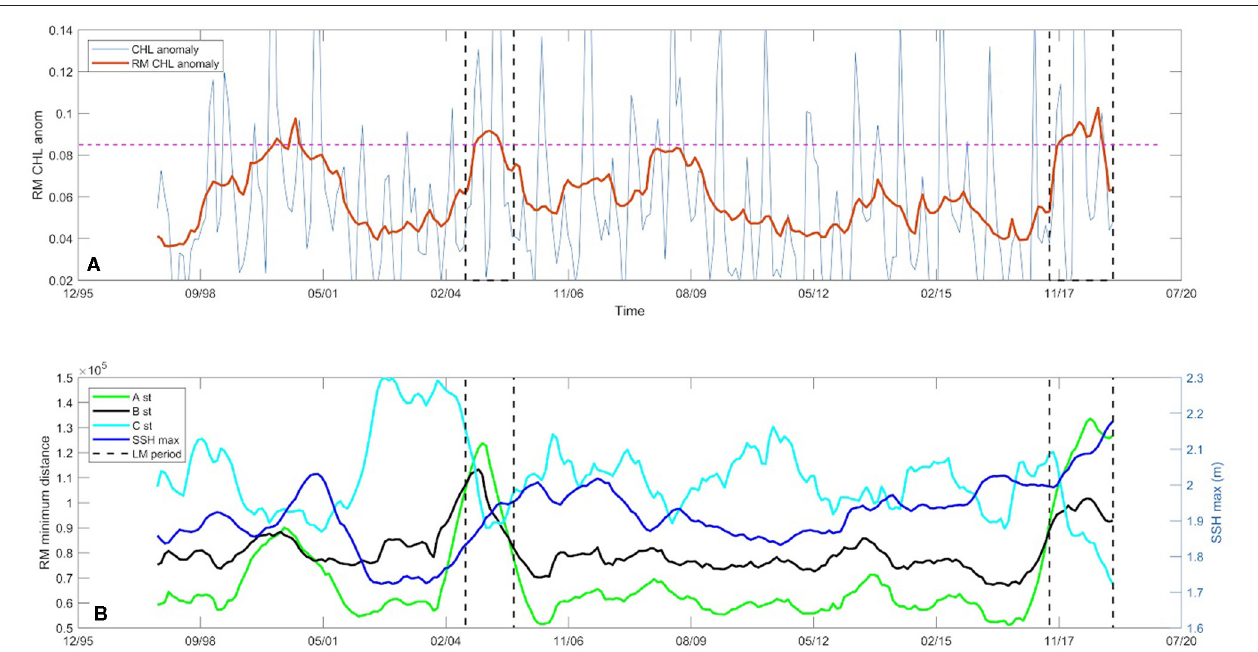
FIGURE 9 | Time series of the 13 month running-mean chlorophyll-a anomaly within the selected area in the LM is shown as red with monthly values in blue line. Black dashed lines indicate the LM periods (A) . Time series of the minimum distance from the stations A (green), B (black), and C (cyan) to the Kuroshio axis defined with the SSH value at 1.2 m with a 13-month running average. Blue line indicates the 13 month running mean maximum SSH value in the recirculation gyre (B)